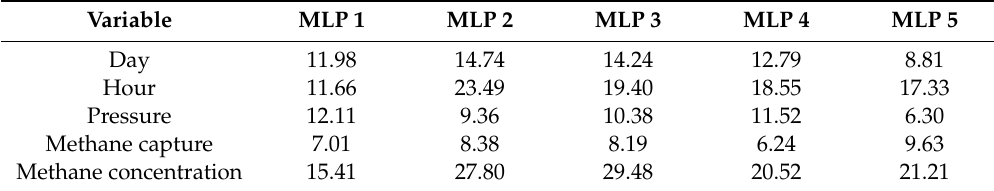
Table 9. Sensitivity analysis of inputs.